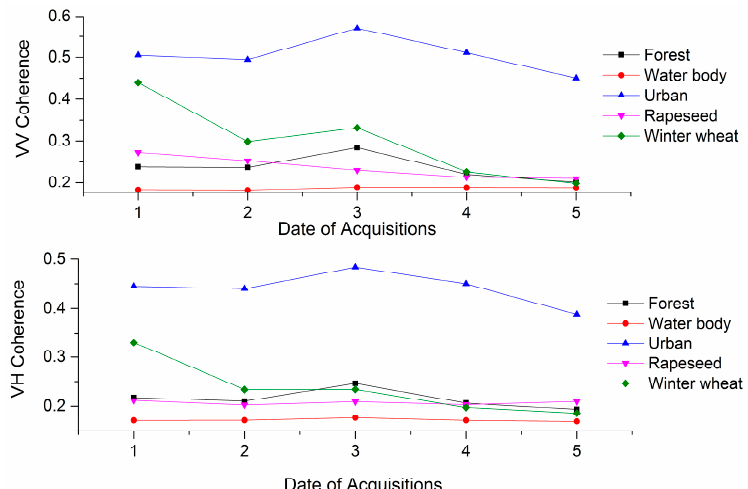
Figure 3. Average coherence values for each land cover class. Note: the meaning of the notation 1, 2, 3, 4, and 5 can be found in Section 3.2.2.